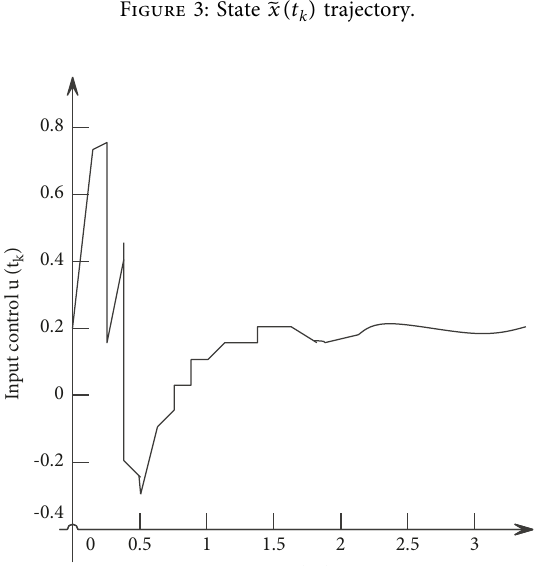
Figure 3: State 􏽥 x ( t